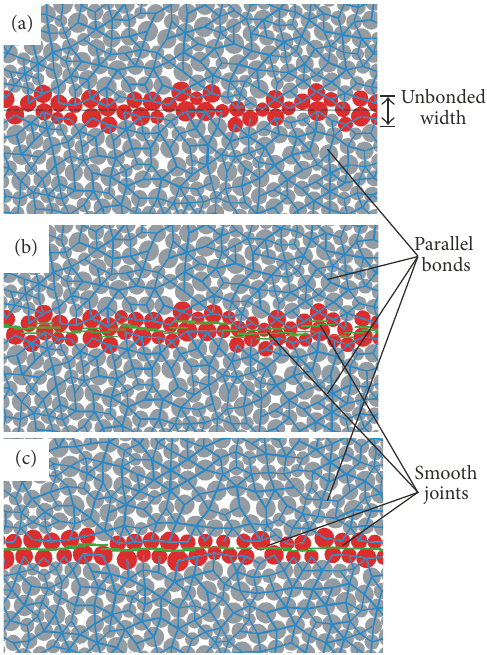
Figure 1: The three different modeling methods for bedding planes.